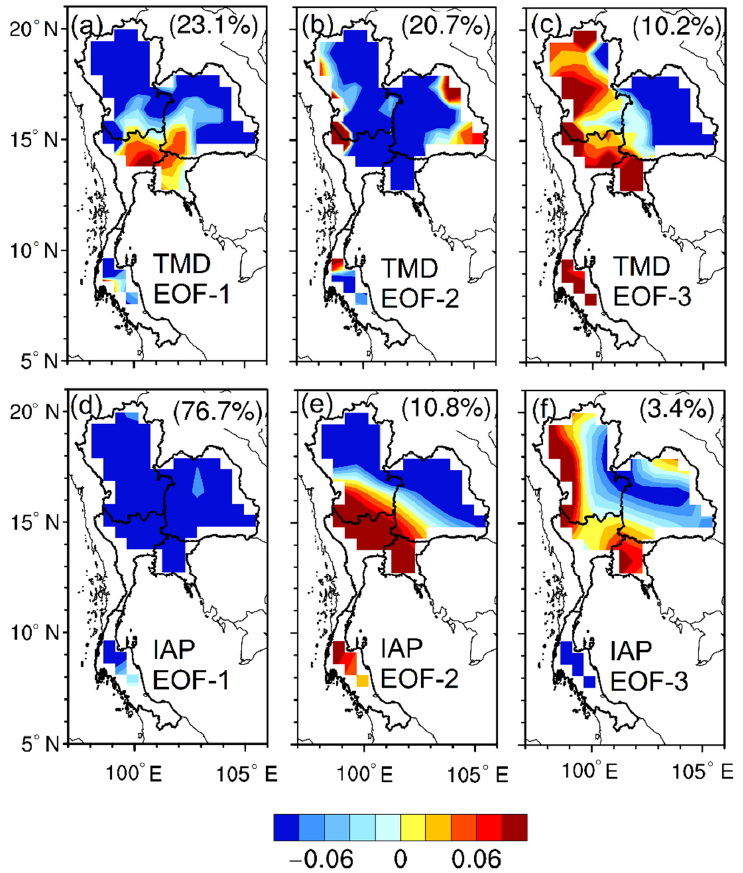
Figure 5. Spatial distribution of the first three dominant EOF modes of summer rainfall over Thailand during 1981–2012: ( a – c ) observed; ( d – f ) IAP ‐ AGCM4.1 simulation. Numbers in parenthesis indicate the explained variance.